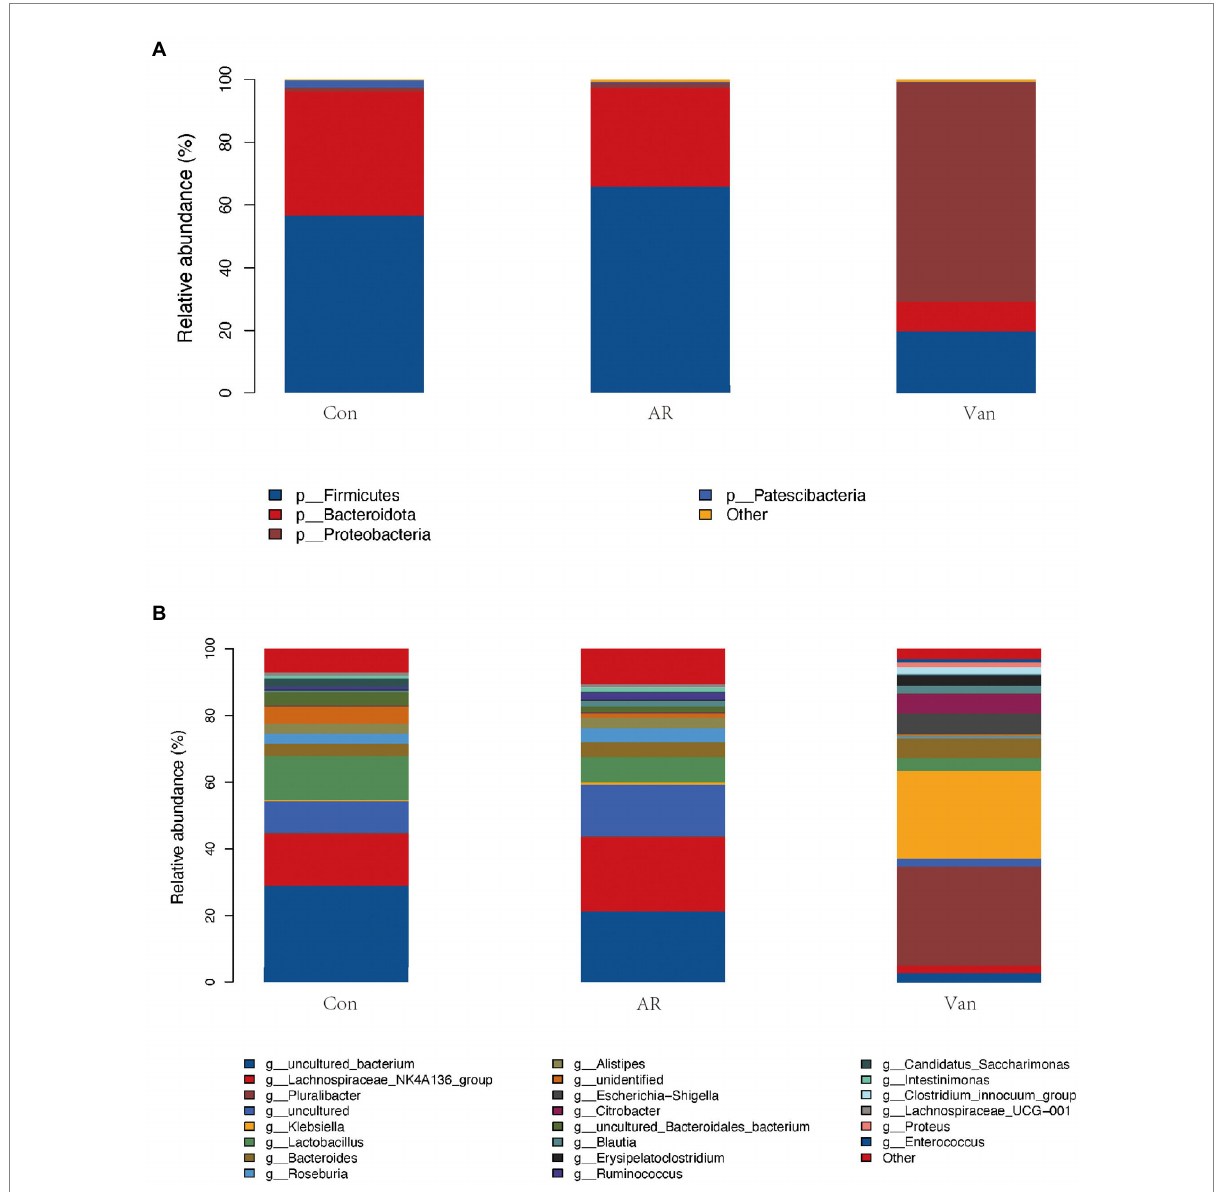
FIGURE 6 Vancomycin-induced gut microbiota dysbiosis altered the proportion of gut microbiota in the OVA-induced AR model. (A) Histogram of species composition analysis at the phylum level. (B) Histogram of species composition analysis at the genus